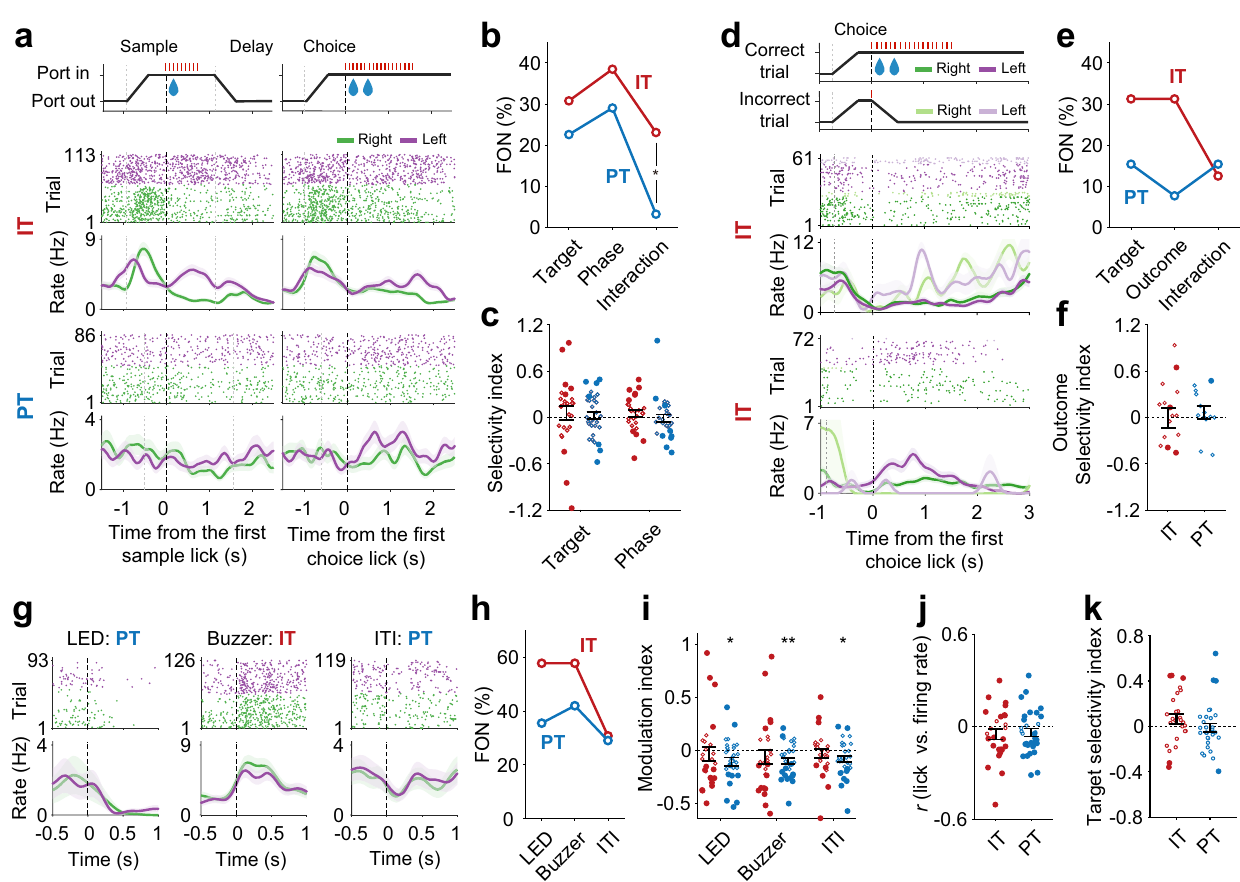
Fig. 7 IT and PT neurons are responsive to diverse task events. a Example neuronal responses during the sample and choice phases in correct trials. Top, schematic of task phases. Bottom, spike rasters and spike density functions ( σ = 100 ms) of two example neurons responsive to target (upper) or phase (lower; two-way mixed measures ANOVA). Trials were grouped according to target (green, right lick port; purple, left lick port). b Fractions of neurons (FON) signi fi cantly responsive to target, phase, and their interaction. * p < 0.05 (Fisher ’ s exact test). c Response selectivity to target (positive and negative, higher responses to the ipsilateral and contralateral targets, respectively; sample- and choice-phase data combined) or phase (positive and negative, higher activity during the sample and choice phases, respectively; ipsilateral- and contralateral-target trials combined). d Example neurons showing outcome- dependent fi ring during the choice phase. Trials were grouped according to target (green and purple) and outcome (saturated and soft colors, correct and error trials, respectively). e Fractions of neurons signi fi cantly responsive to target, outcome, and their interaction (two-way ANOVA). f Response selectivity to outcome (positive and negative, higher activity in correct and error trials, respectively). g Example neurons showing differential fi ring between before and after LED, buzzer, or ITI onset. h Fractions of neurons signi fi cantly (paired t -test, 0.5-s windows before and after event onset were compared) responsive to LED, buzzer, or ITI onset. i Distributions of event modulation index (positive and negative, higher and lower fi ring after than before event onset, respectively). * p < 0.05, ** p < 0.01 (difference from 0, t -test). j Distributions of correlation coef fi cient between lick rate and fi ring rate. k Target selectivity index during the 1-s time period before the fi rst choice lick. Filled and open circles denote signi fi cantly and insigni fi cantly responsive neurons, respectively, in c , f , and i – k . Shading, SEM across trials ( a , d , and g ). Error bars, SEM across neurons ( c , f , and i – k ). Only correct trials were analyzed ( n = 26 IT and 31 PT neurons) except the analyses related to outcome-dependent neural activity ( d – f ; n = 16 IT and 13 PT neurons recorded in the sessions with ≥ 2 error trials for both targets).